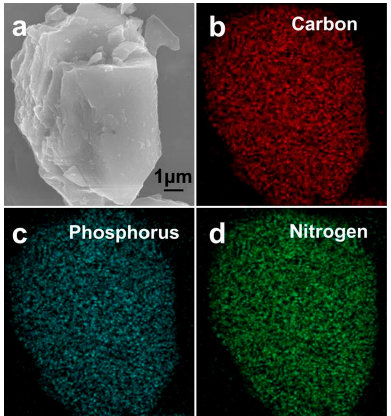
Figure 2. ( a ) SEM images of a red phosphorus/nitrogen-doped carbon composite (RPNC) composite particle; ( b – d ) Energy Dispersive Spectrometer (EDS) mapping showing distribution of carbon, phosphorus and nitrogen.